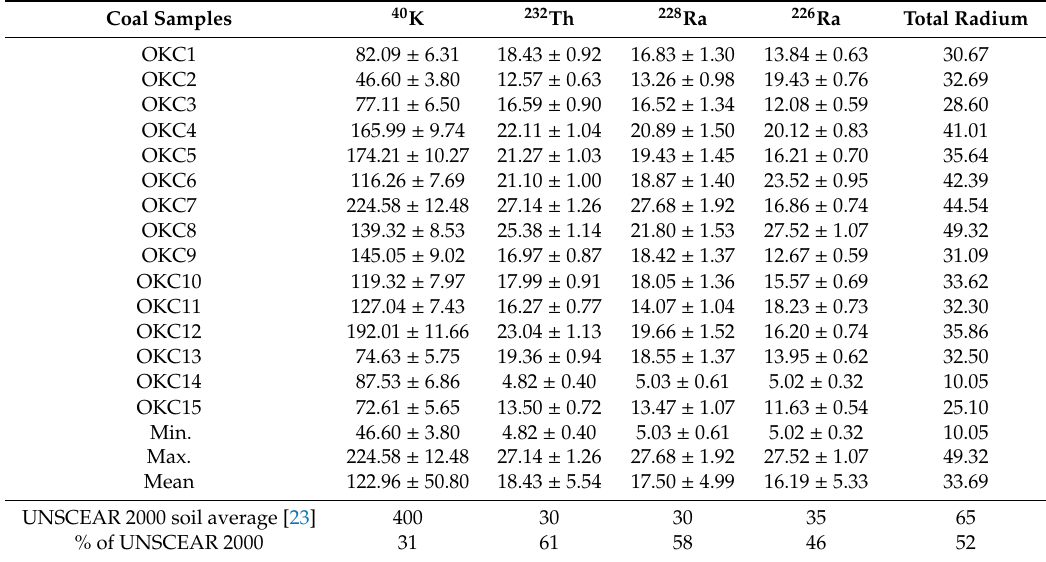
Table 2. Activity concentration of radionuclides in Okaba coal samples (Bqkg − 1 ). Coal Samples